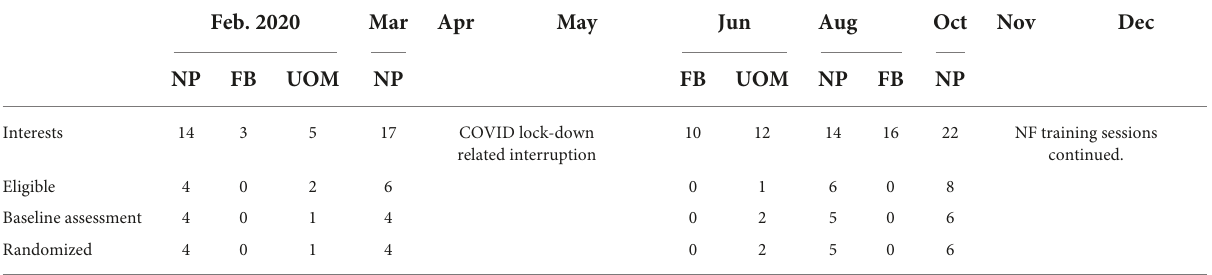
TABLE 2 Recruitment and data collection timeline.